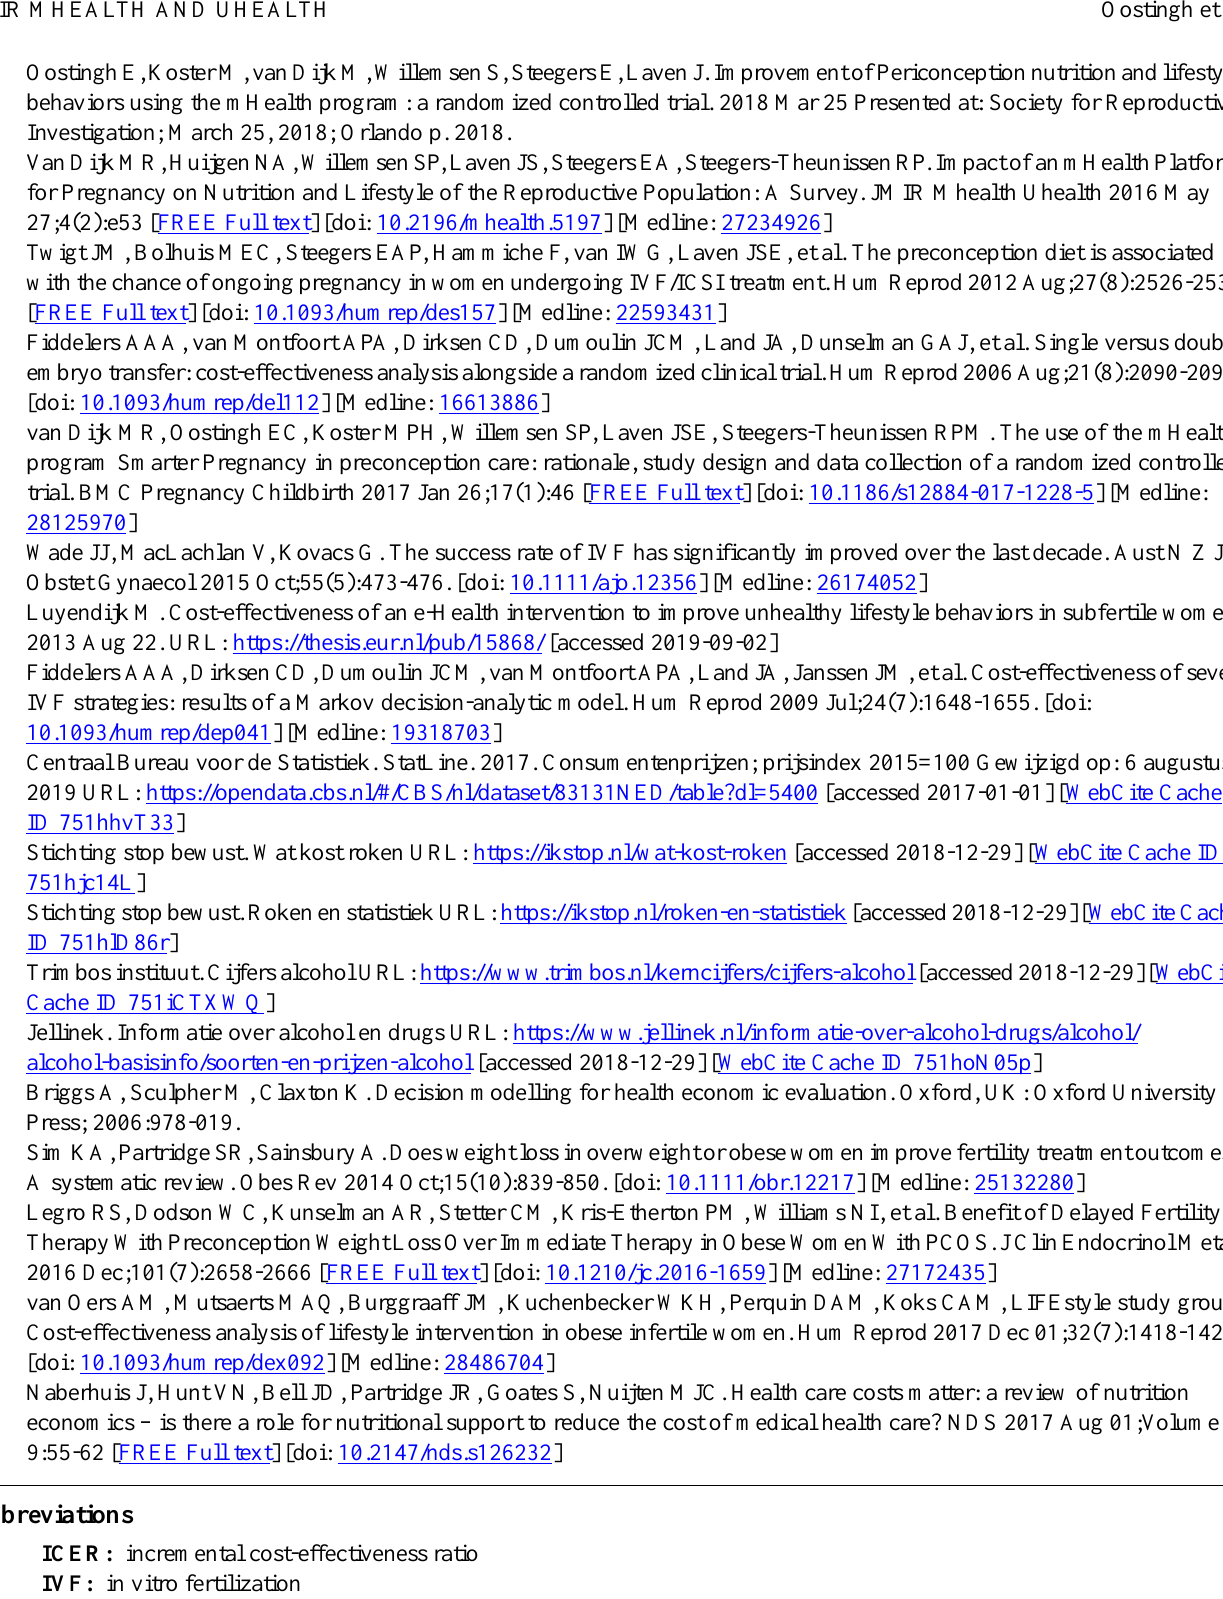
ICER: incremental cost-effectiveness ratio IVF: in vitro